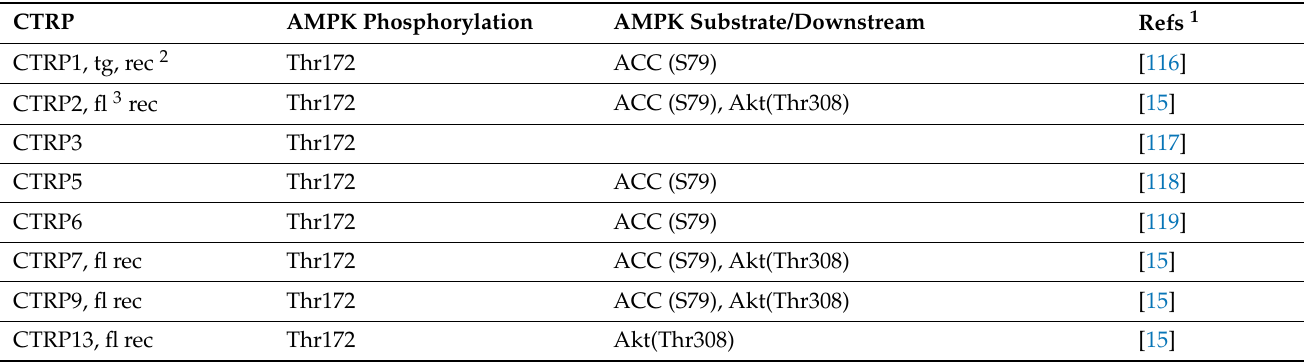
Table 4. Recombinant (rec) CTRP-induced AMPK